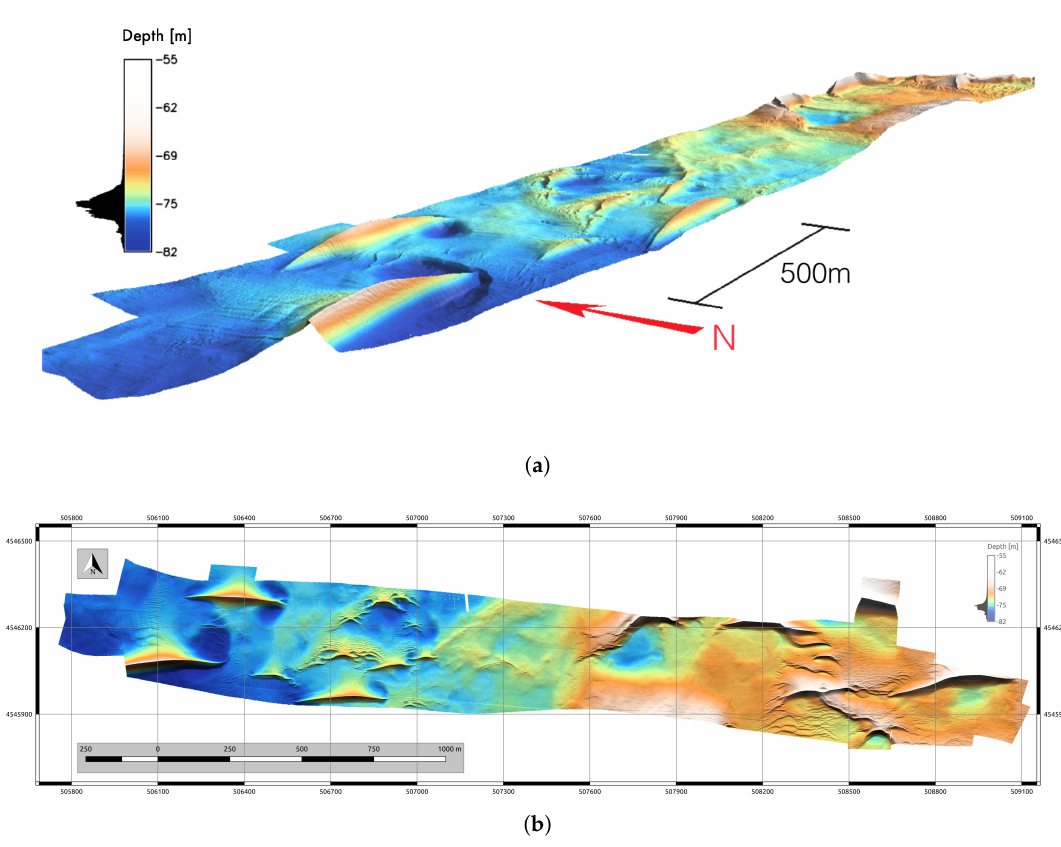
Figure 3. Digital Bathymetry produced from the MBES data set., cell size 1 m × 1 m. ( a ) Sout West 3D perspective, vertical exaggeration 3 × ; ( b ) Shaded relief, Azimuth of the sun in degrees to the east of north: 0 ◦ , Altitude of the sun in degrees above the horizon: 50 ◦ ; Factor for exaggerating relief: 3 ×